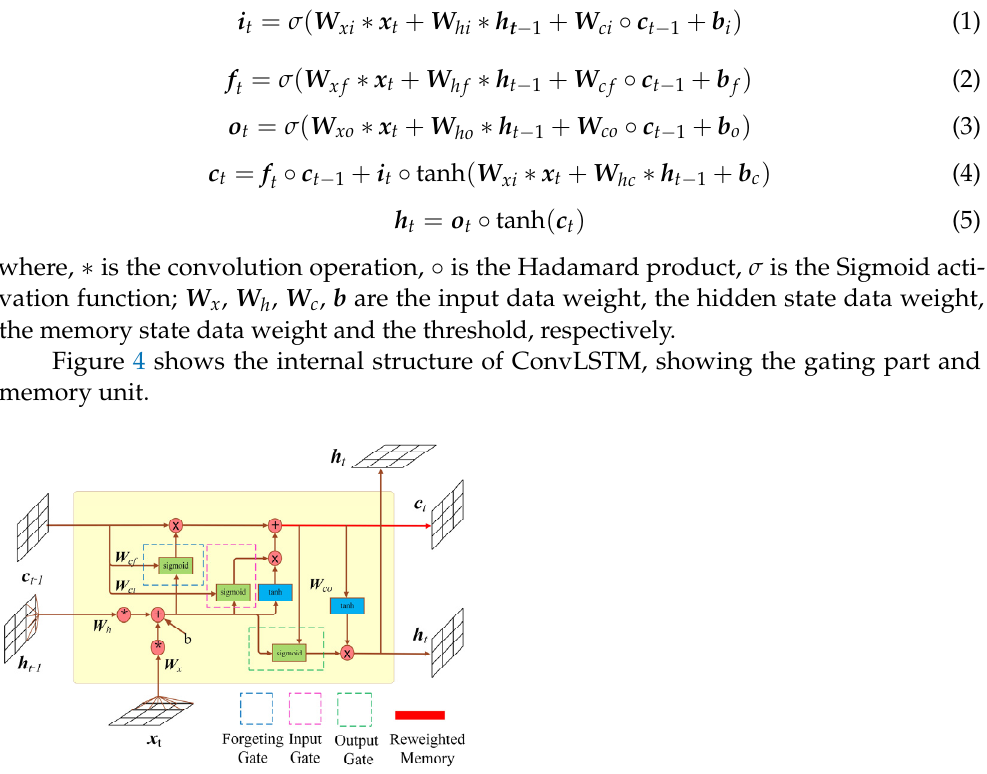
Figure 4. ConvLSTM Cell structure. In Figure 4, the blue dashed box represents the forget gate; the pink dashed box represents the input gate; the green dashed box represents the output gate; the red solid line represents the reweighted memory